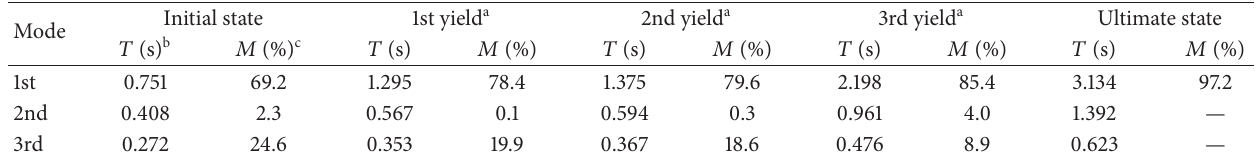
Table 3: Modal characteristics of